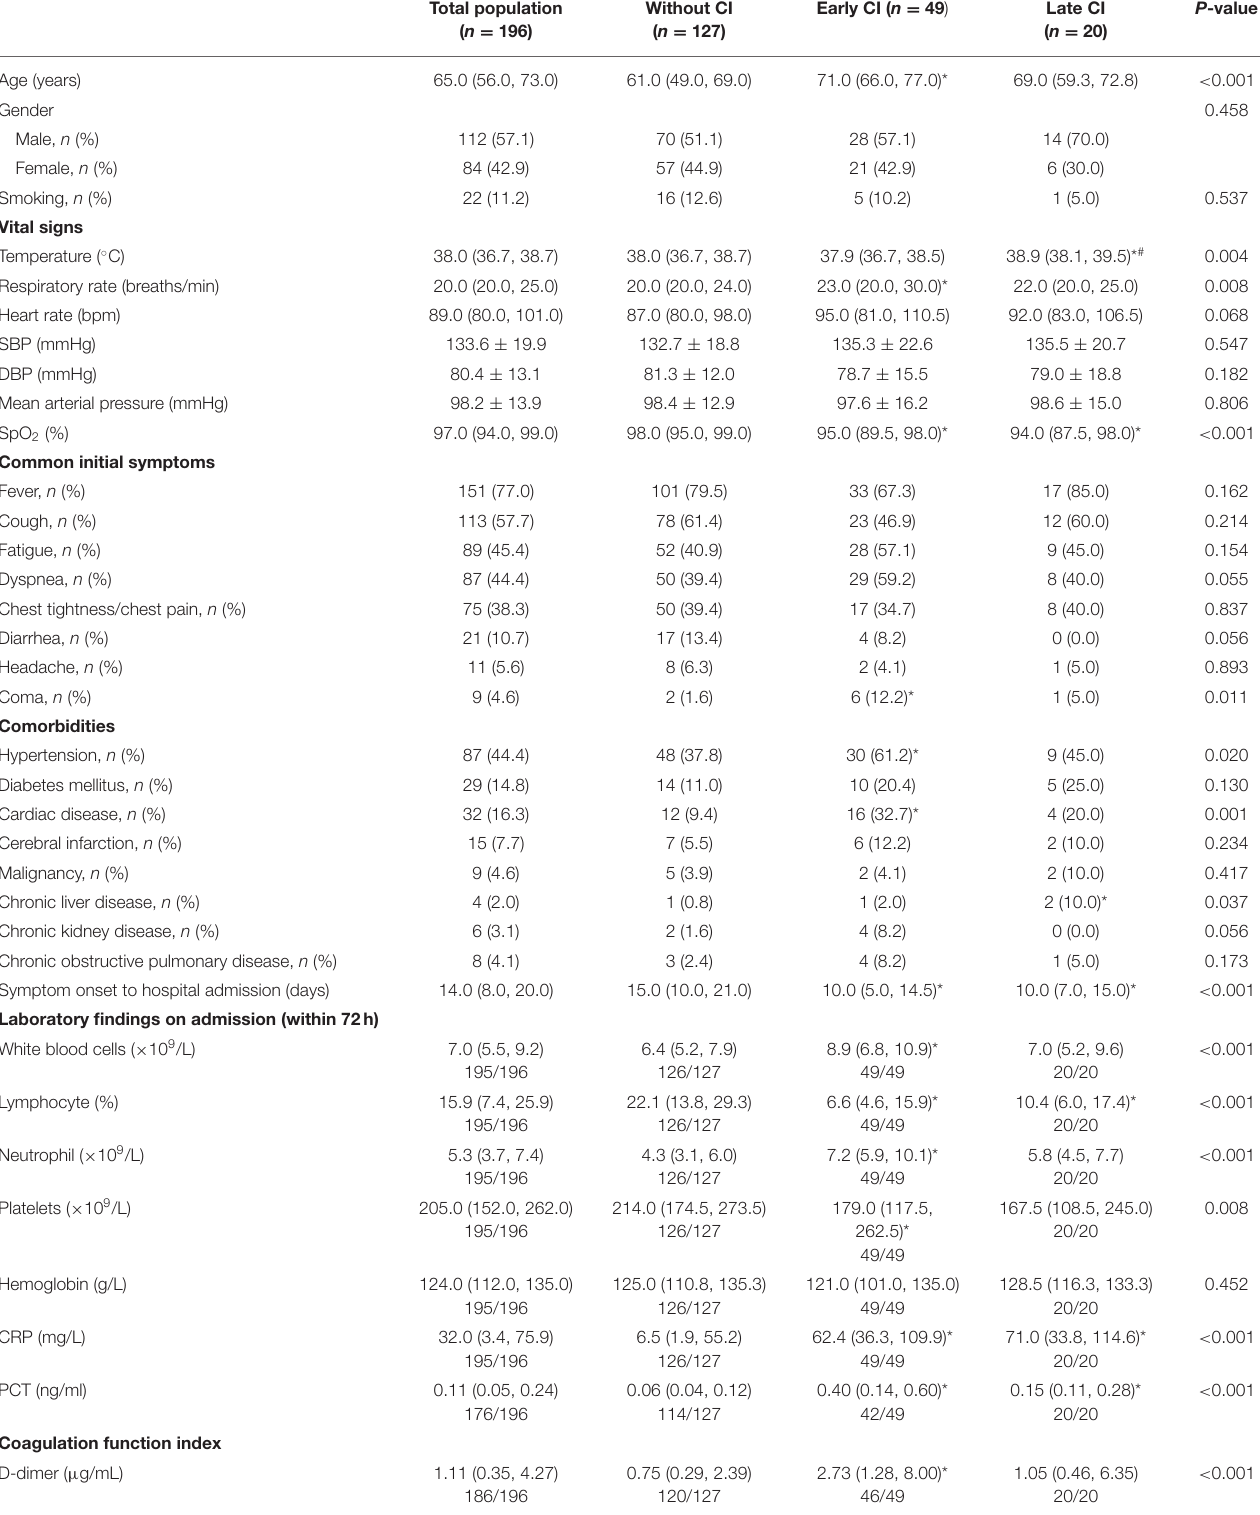
TABLE 1 | Comparisons of demographics, clinical characteristics and laboratory examinations on admission within 72h among the three